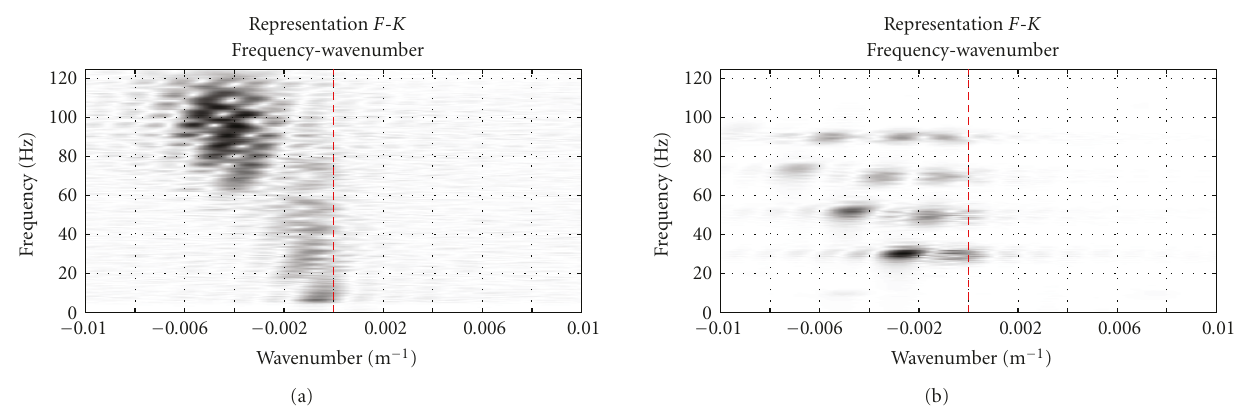
Figure 7: F - K transforms of sections r - t simulated with source ULF-1 at 105 m (a) and source ULF-2 at 70 m